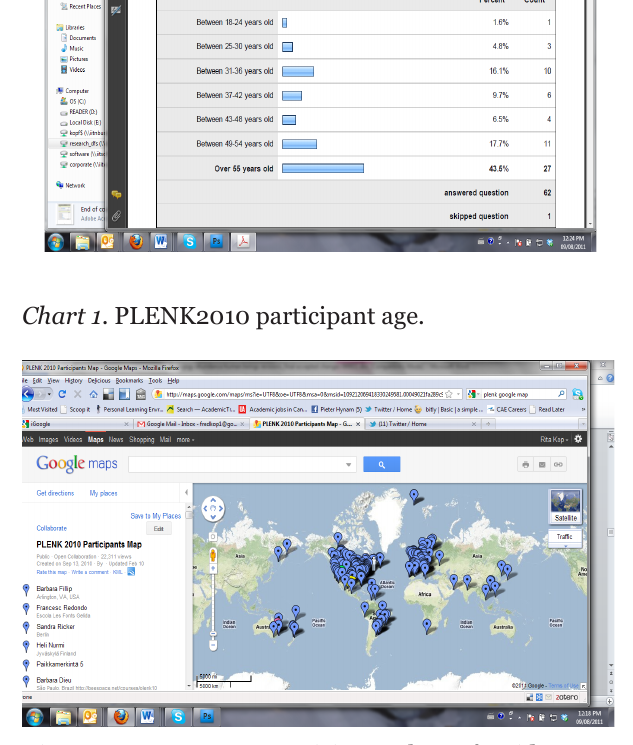
Figure 2. PLENK2010 participant place of